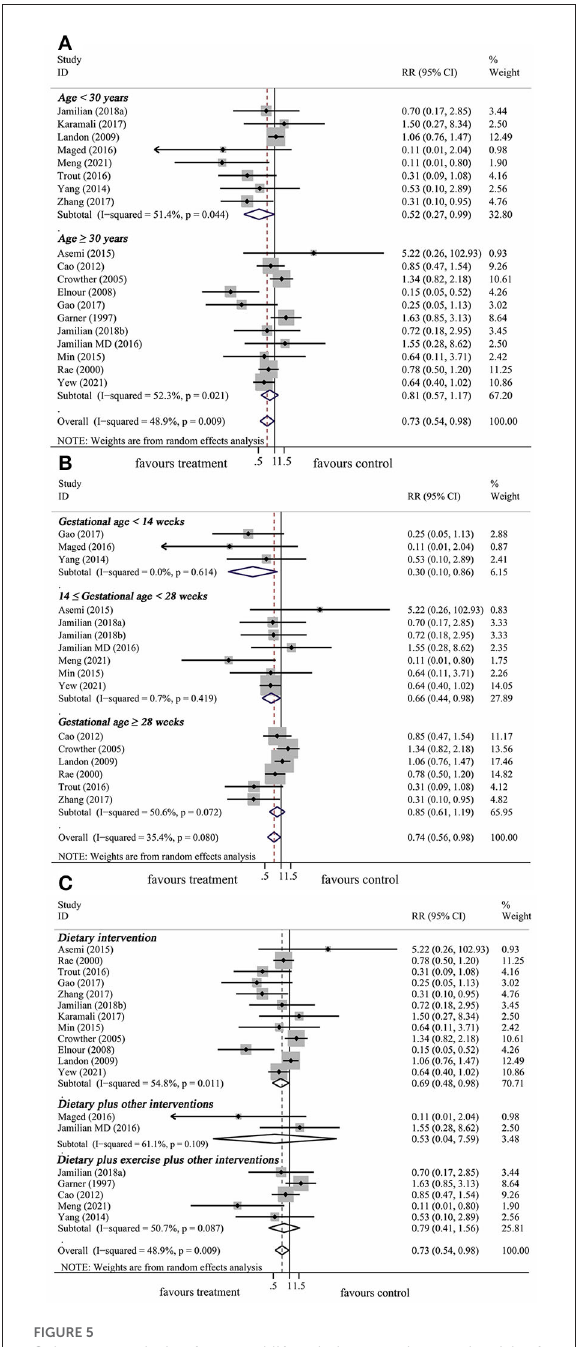
FIGURE5 Subgroup analysis of prenatal lifestyle intervention on the risk of neonatal hypoglycemia stratified by maternal age at pregnancy (A) , gestational age at baseline (B) , and intervention types (C) .